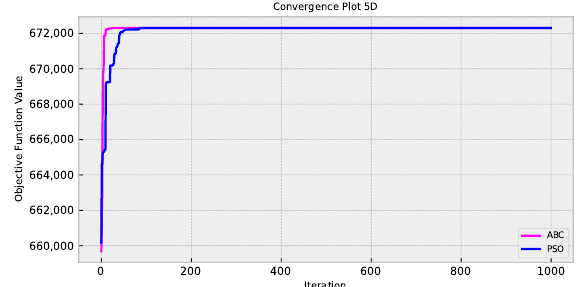
Figure 5. Convergence plot for 5D at 10 m/s mean wind speed.